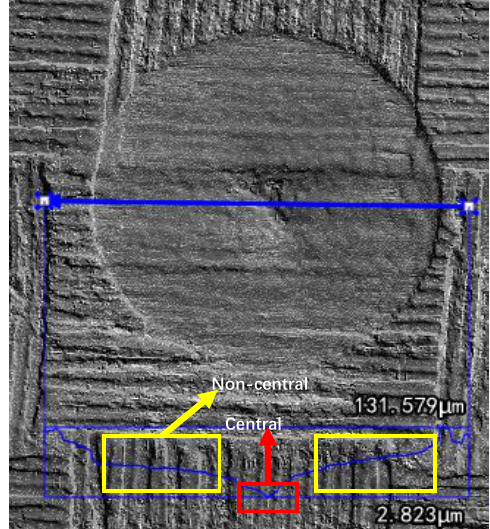
Figure 6. The depth distribution along diameter of the hole measured by confocal microscope.